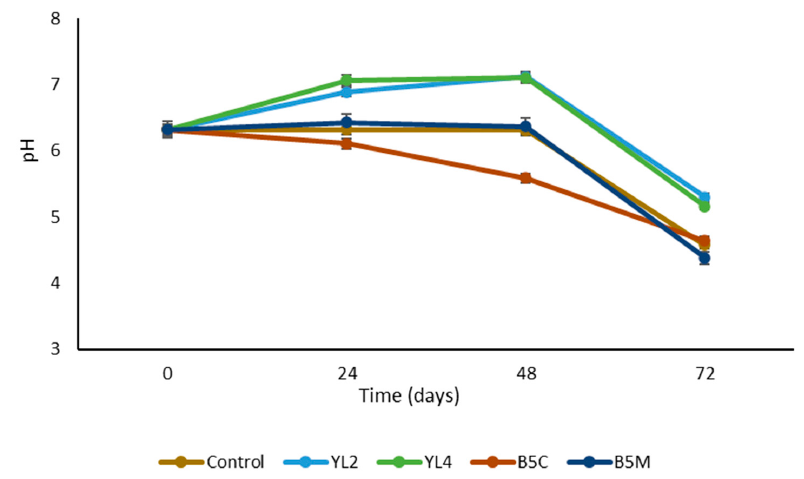
Figure 1. pH profile of the fish waste samples incubated with the different selected strains. Control is fish waste without additional microorganisms. Results are the mean of three repetitions ( n = 3).